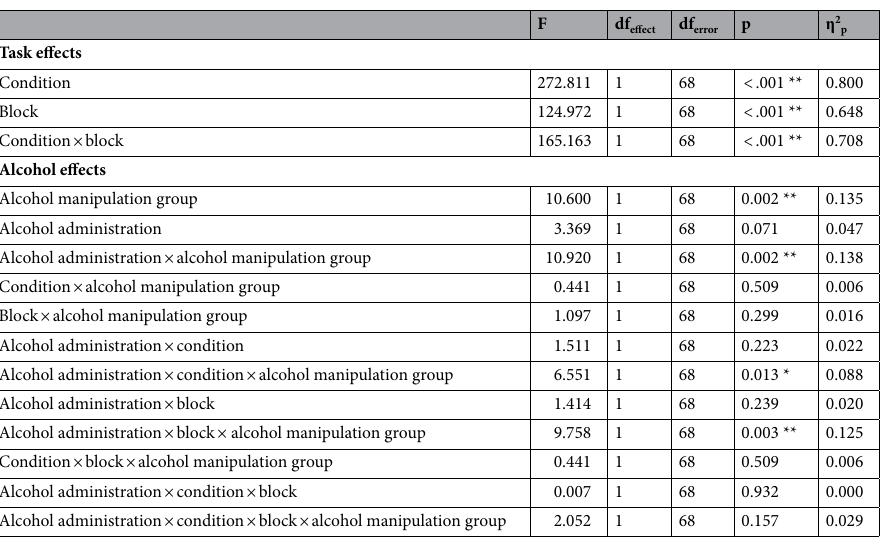
Table 2. Main and interaction effects of the mixed 2 × 2 × 2 × 2 ANOVA for entire sequence duration. *p < .05; **p <